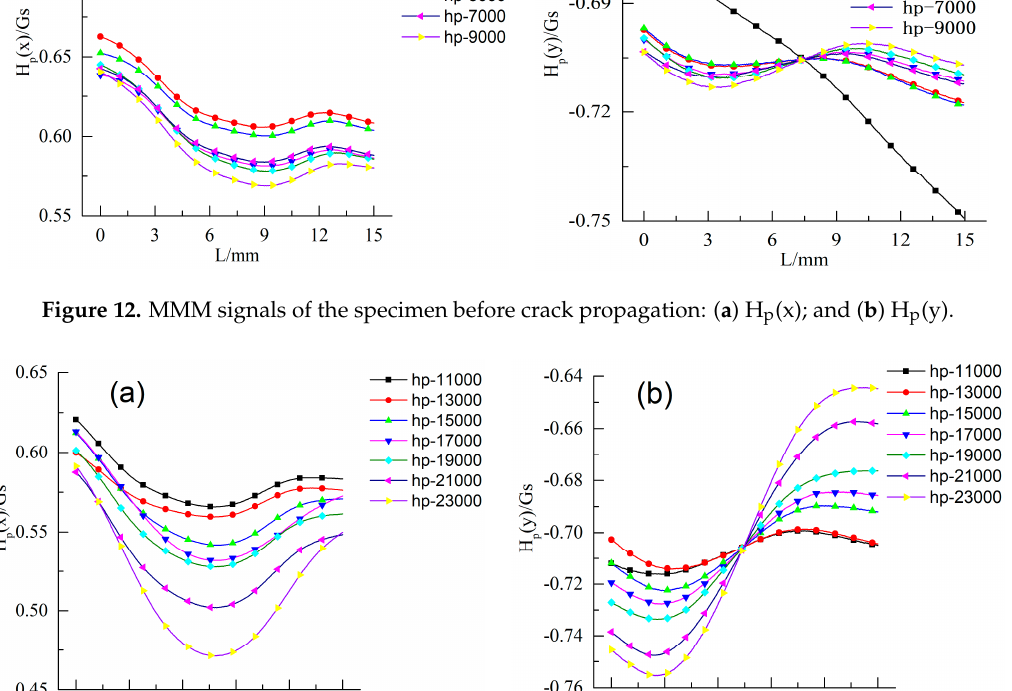
Figure 13. MMM signals of the specimen after crack propagation: ( a ) H p (x); and ( b ) H p (y).